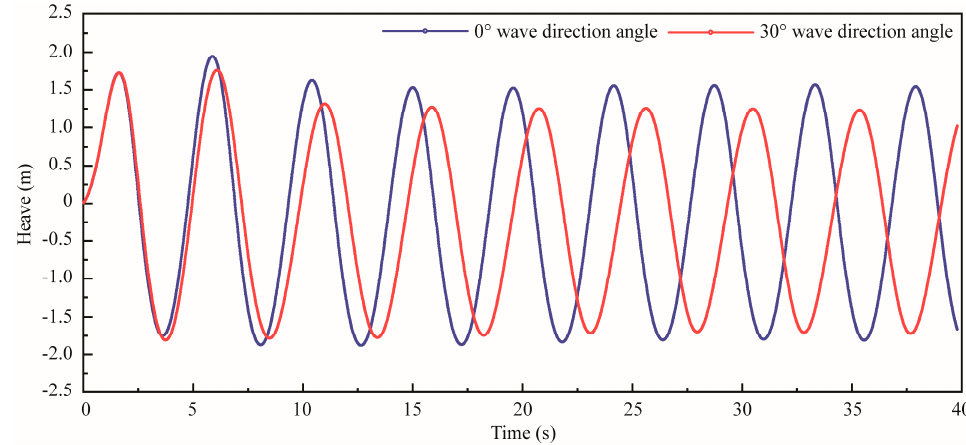
Figure 16. The heave motion with different wave direction angles at 5 level sea state.